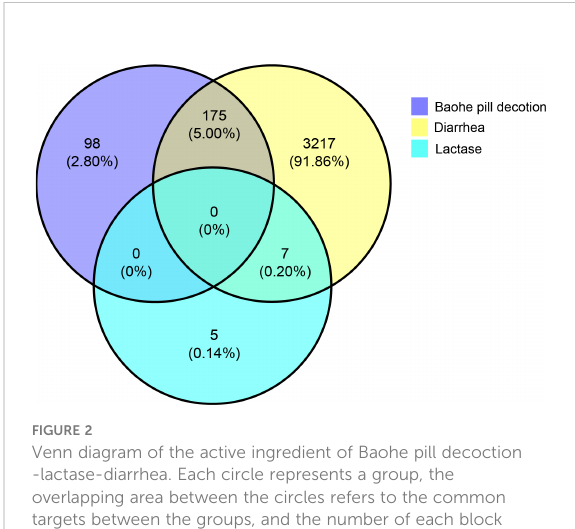
FIGURE 2 Venn diagram of the active ingredient of Baohe pill decoction -lactase-diarrhea. Each circle represents a group, the overlapping area between the circles refers to the common targets between the groups, and the number of each block indicates the number of targets contained in the